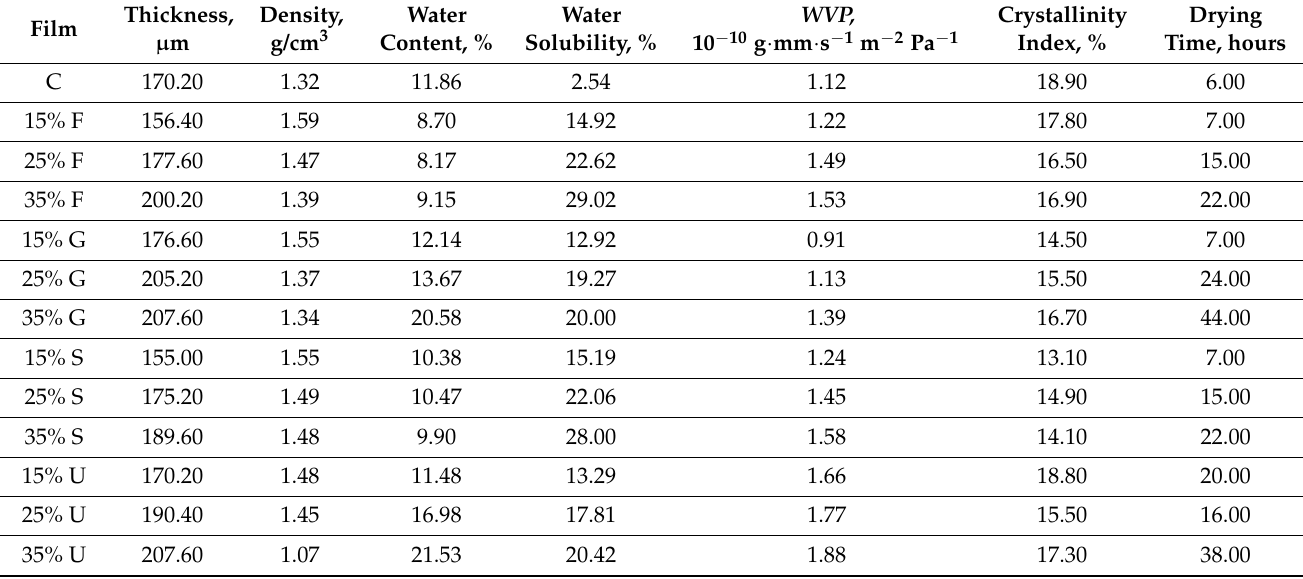
Table 1. Physical properties, WVP , crystallinity and drying time of wheat starch-based films and various